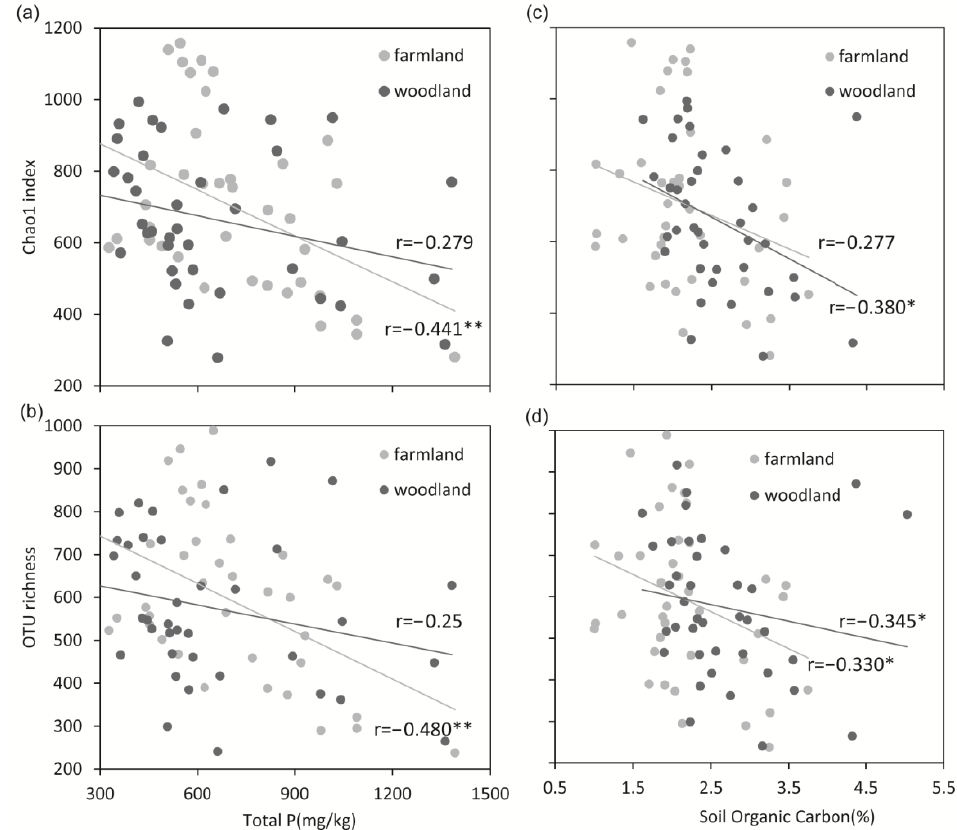
Figure 3. Relationship between arbuscular mycorrhizal fungal Chao1 index and total p or SOC ( a , c ) and OTU richness and total p or SOC ( b , d ) of the farmland and woodland sampling sites. * p < 0.05 and ** p < 0 .01 by Turkey’s test.